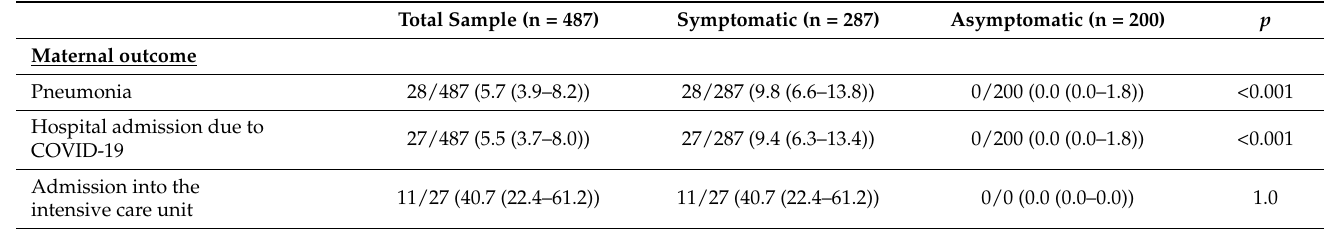
Table 2. Maternal and perinatal outcomes of 487 pregnancies with SARS-CoV-2 infection, overall and according to the presence of